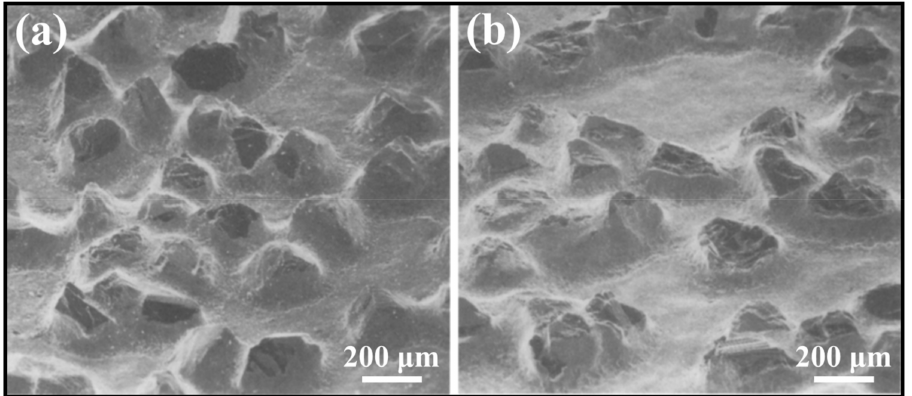
Figure 16. Surface topography of the diamond grit button fabricated with Ni-Cr hardfacing alloy ( a ) before grinding and ( b ) after grinding. Reprinted with permission from Ref. [73]. Copyright 1991,